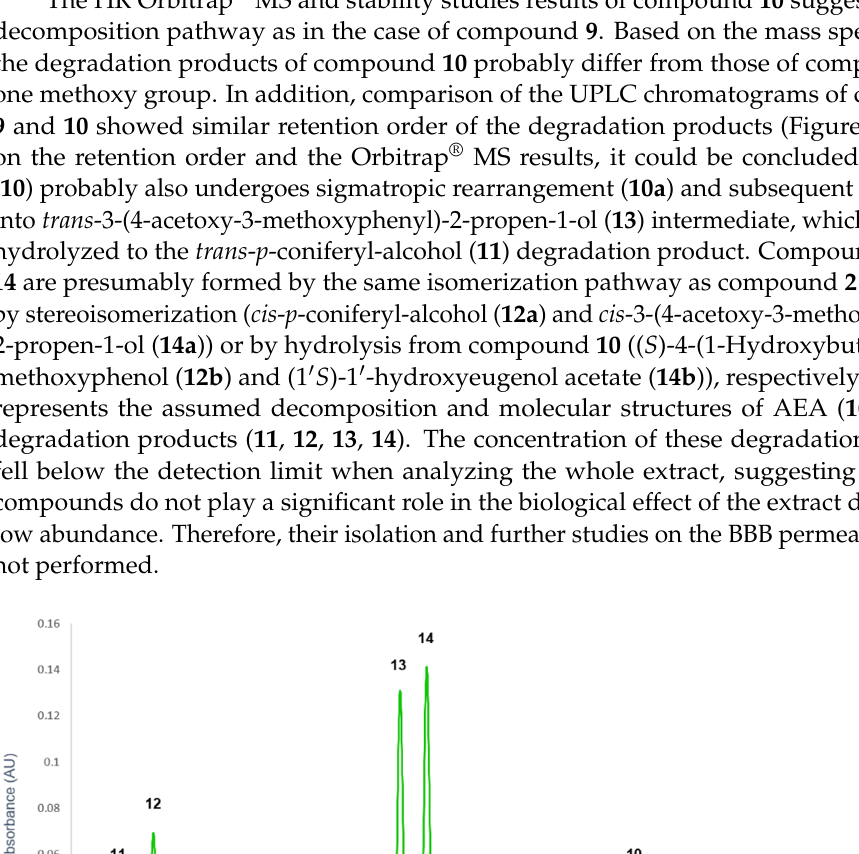
Figure 10. Assumed decomposition of 1′ S -1′-acetoxyeugenol acetate ( 10 ). Compound 10 probably undergoes sigmatropic rearrangement ( 10a ) and subsequent hydrolysis into trans -3-(4-acetoxy-3- methoxyphenyl)-2-propen-1-ol ( 13 ) intermediate, which is transformed by hydrolysis to the trans - p -coniferyl-alcohol ( 11 ) degradation product. The tentative isomer structures in the case of the deg- radation product 14 are: cis- 3-(4-acetoxy-3-methoxyphenyl)-2-propen-1-ol ( 14a ) and (1′ S )-1′-hydrox- yeugenol acetate ( 14b ). The putative isomer structures in the case of degradation product 12 are: cis - p -coniferyl-alcohol ( 12a ) and ( S )-4-(1-Hydroxybut-3-enyl)-2-methoxyphenol ( 12b ). 4.2. PAMPA-BBB Among the compounds isolated from greater galangal, p -OH-benzaldehyde ( 1 ), trans - p -coumaryl-alcohol ( 2 ), and p -coumaryl-aldehyde ( 4 ) possessed log P e values greater than −6.0 (−5.56 ± 0.07, −5.86 ± 0.23, and −5.25 ± 0.27, respectively); therefore, these constit- uents can be considered to be able to cross the blood–brain barrier via passive diffusion. Although trans - p -acetoxycinnamyl alcohol ( 7 ), ACA ( 9 ), and AEA ( 10 ) also possessed log P e values greater than -6.0, these results cannot be used to evaluate the passive diffusion ability of these compounds due to their instability. However, the results allow the as- sumption that these components have good BBB penetration capability. In addition, Mori- kawa et al. demonstrated that, among the isolated compounds, trans - p -coumaryl-alcohol ( 2 ), p -coumaryl-aldehyde ( 4 ), galanganol B ( 6 ), ACA ( 9 ), and AEA ( 10 ) showed nitric oxide (NO) production inhibitory activities in mouse peritoneal macrophages, which is a possi- ble mechanism of the potential neuroprotective effect [11]. Nevertheless, galanganol A ( 5 ) and B ( 6 ) possessed log P e values of −6.11 ± 0.18 and −6.14 ± 0.20, respectively, suggesting them to be unable to cross the BBB via passive diffusion. Although the high throughput nature, good reproducibility, and cost-effectiveness of the PAMPA model makes it an